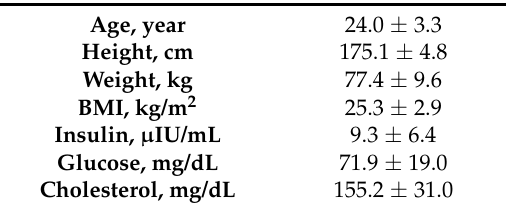
Table 1. Participant characteristics.